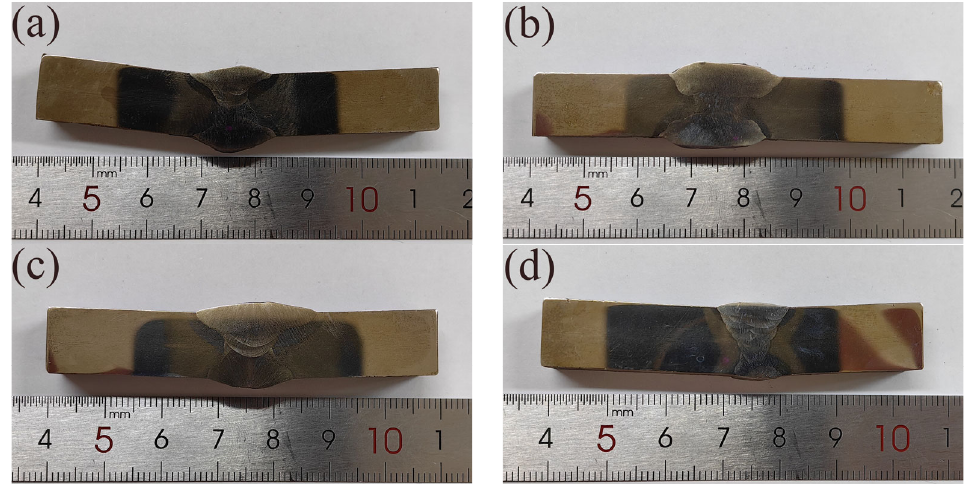
Figure 6. Macroscopic photographs of the welded joints: ( a ) SM ‐ 1; ( b ) SM ‐ 3; ( c ) SA ‐ 1; ( d ) GT ‐ 1.